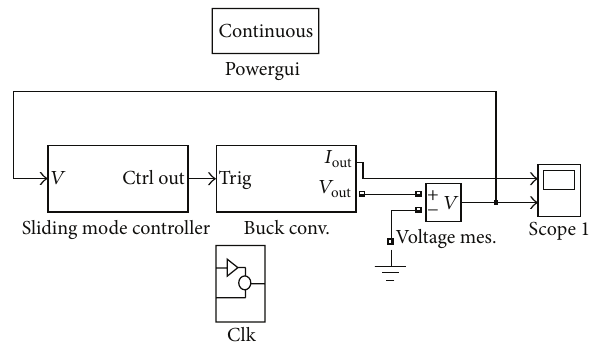
Figure 5: Simulink block diagram of direct sliding mode control.